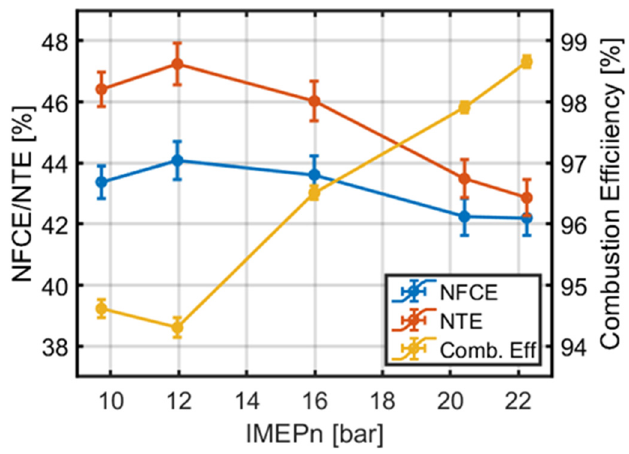
Figure 16. Net fuel conversion (FC) efficiency, net thermal efficiency, and combustion efficiency vs. net indication mean effective pressure (IMEPn).